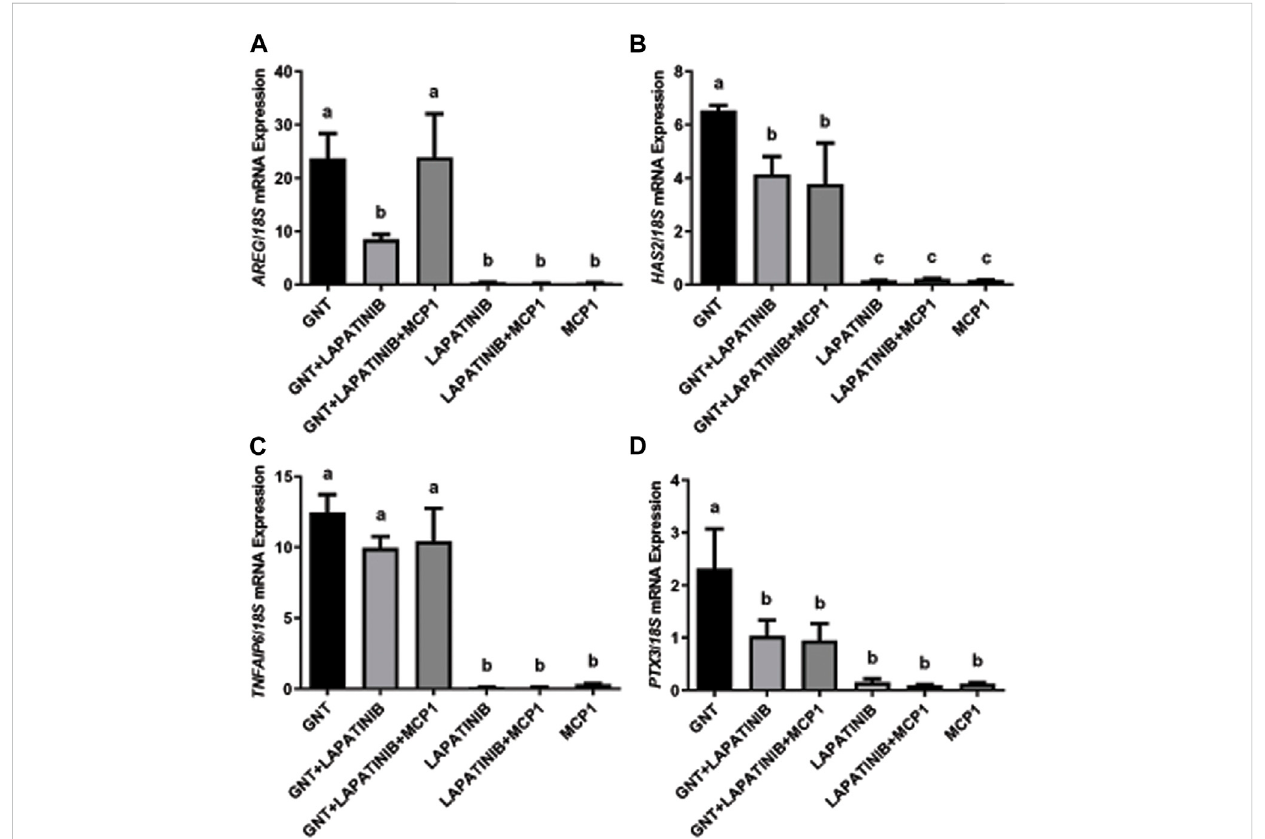
FIGURE 1 MCP1 reverted the inhibition of AREG mRNA by the EGFR inhibitor but not HAS2 or PTX3 in the feline COC in vitro . Normalized AREG (A) , HAS2 (B) , TNFAIP6 (C) ,and PTX3 (D) mRNAexpressionlevels(mean±SEM,n=5 – 6COCspergroup)withintheCOCafter3 hofcultureinthepresenceorabsence of a positive stimulus (GNT), EGFR inhibitor (LAPATINIB), and/or the recombinant chemokine MCP1, assessed by qRT-PCR. 18S rRNA served as the invariantcontrolfornormalization.Differentlettersrepresentsigni fi cantdifferencesbetweengroups(ANOVA; p < 0.05). AREG :amphiregulin, HAS2